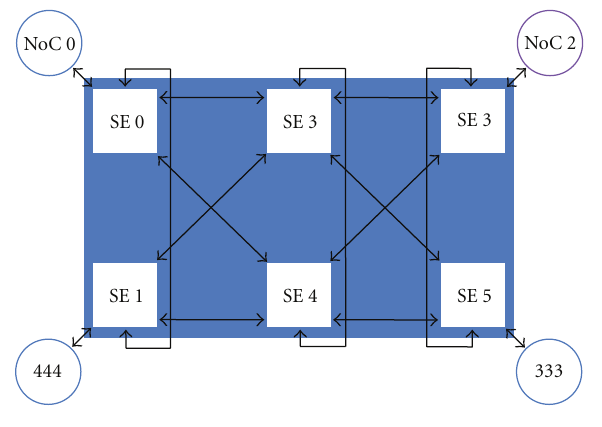
Figure 23: The simulation state of NiP-HXN model at fourth step of worst case.